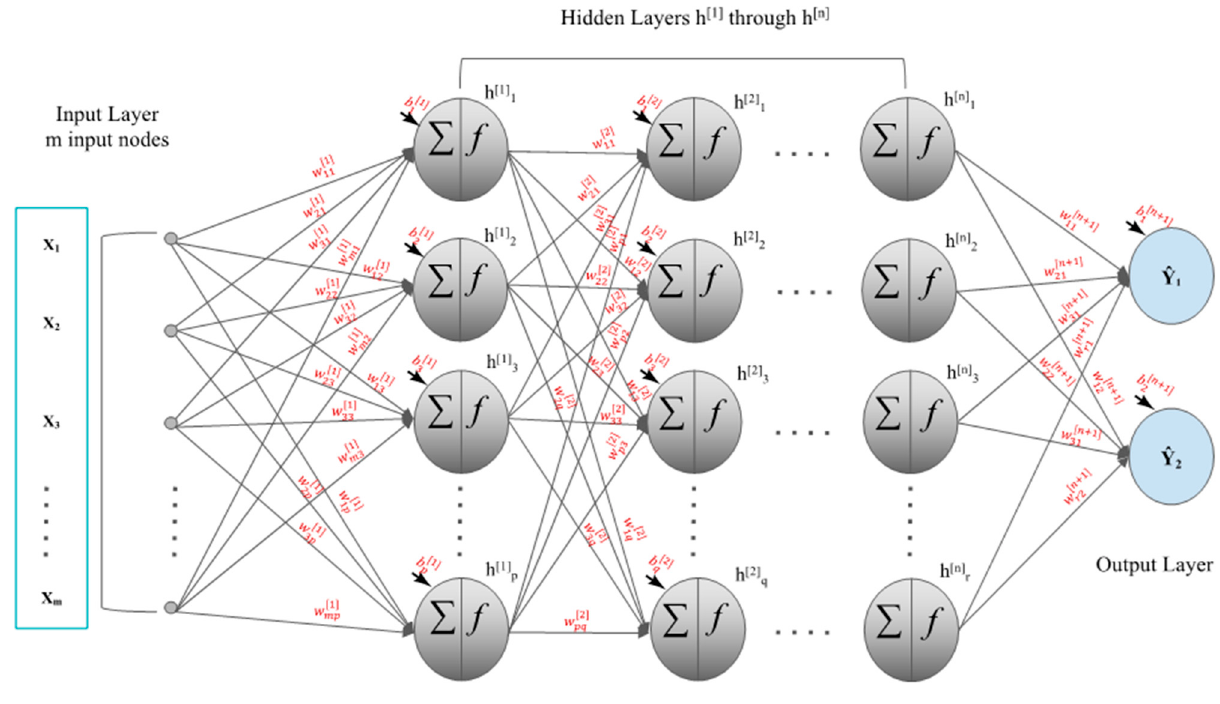
Figure 1. A DFNN (deep feedforward neural network) model that contains n hidden